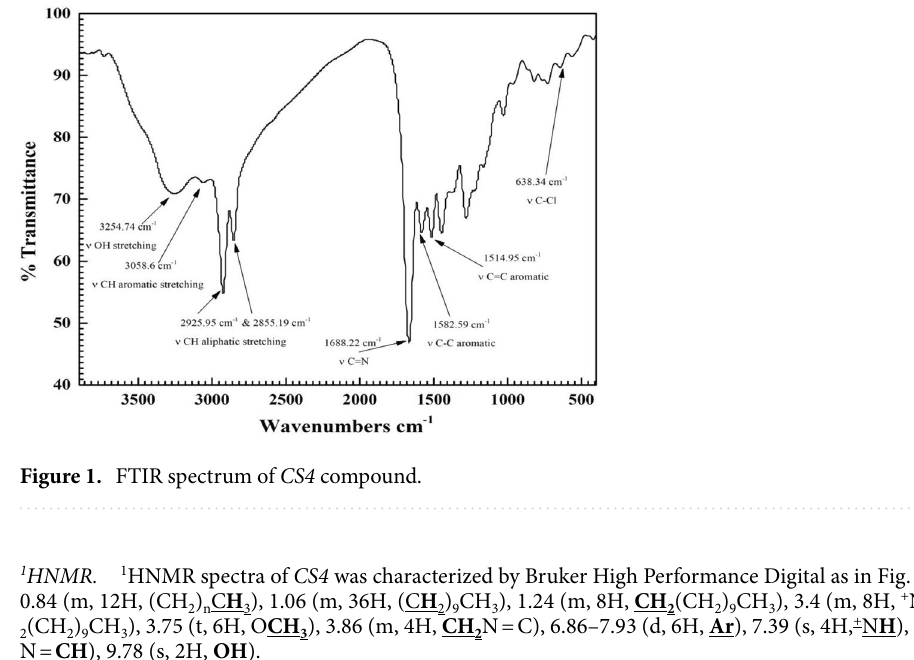
Table 1 as the following equation: